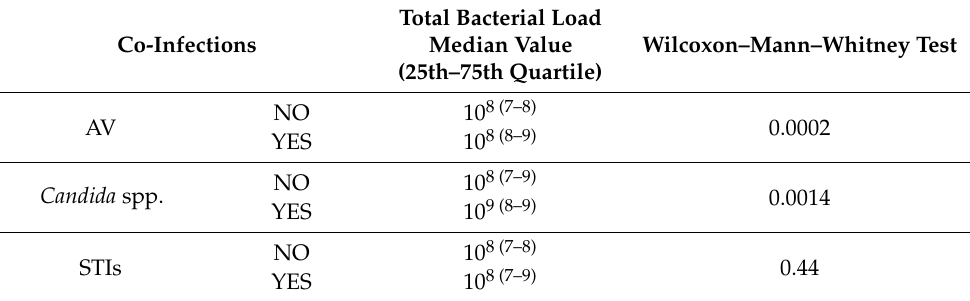
Table 3. Association between bacterial load determined by the qPCR test and the diagnosis of AV and candidiasis.